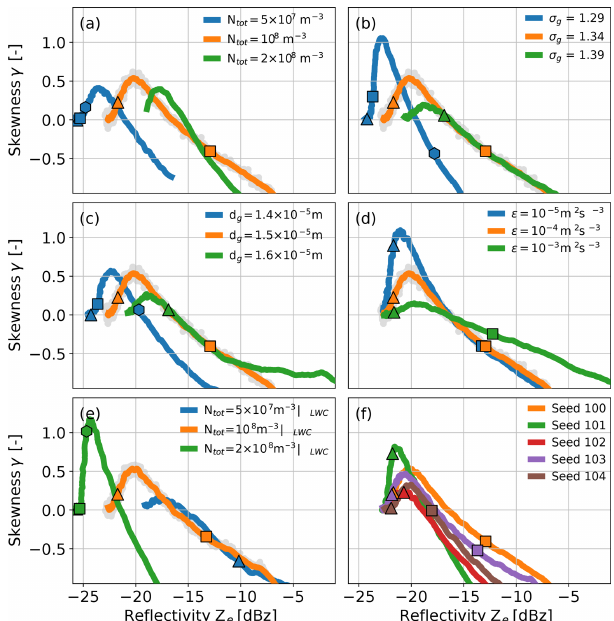
Figure 1. Sensitivity of the reflectivity Z e to skewness γ transition for drizzle onset to (a) total number concentration N tot , (b) the unit- less standard deviation of the lognormal distribution σ g , (c) the ge- ometric mean diameter d g , and (d) the turbulent energy dissipation rate (cid:15) . We also (e) modified N tot while keeping liquid water content (LWC) constant (i.e., increasing d g ) and (f) used different seeds for the box model. All lines are smoothed. The light gray points show all data points of the reference run; the lines denote smoothed model results. The triangles, squares, and hexagonal shapes indicate model simulation times of 1, 1.5, and 2h, respectively. Note that the orange lines are identical for all